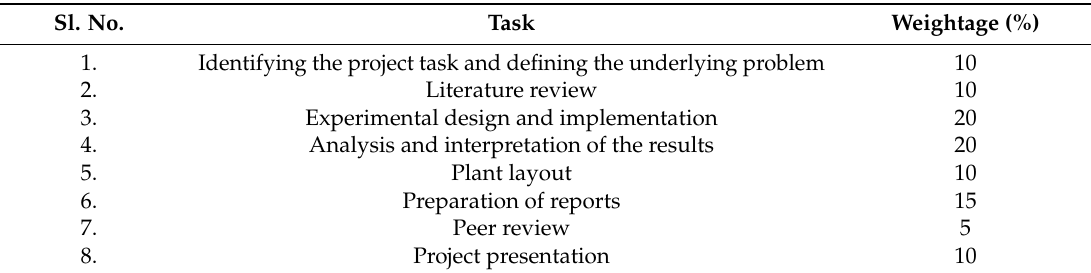
Table 3. For assessment of the project.